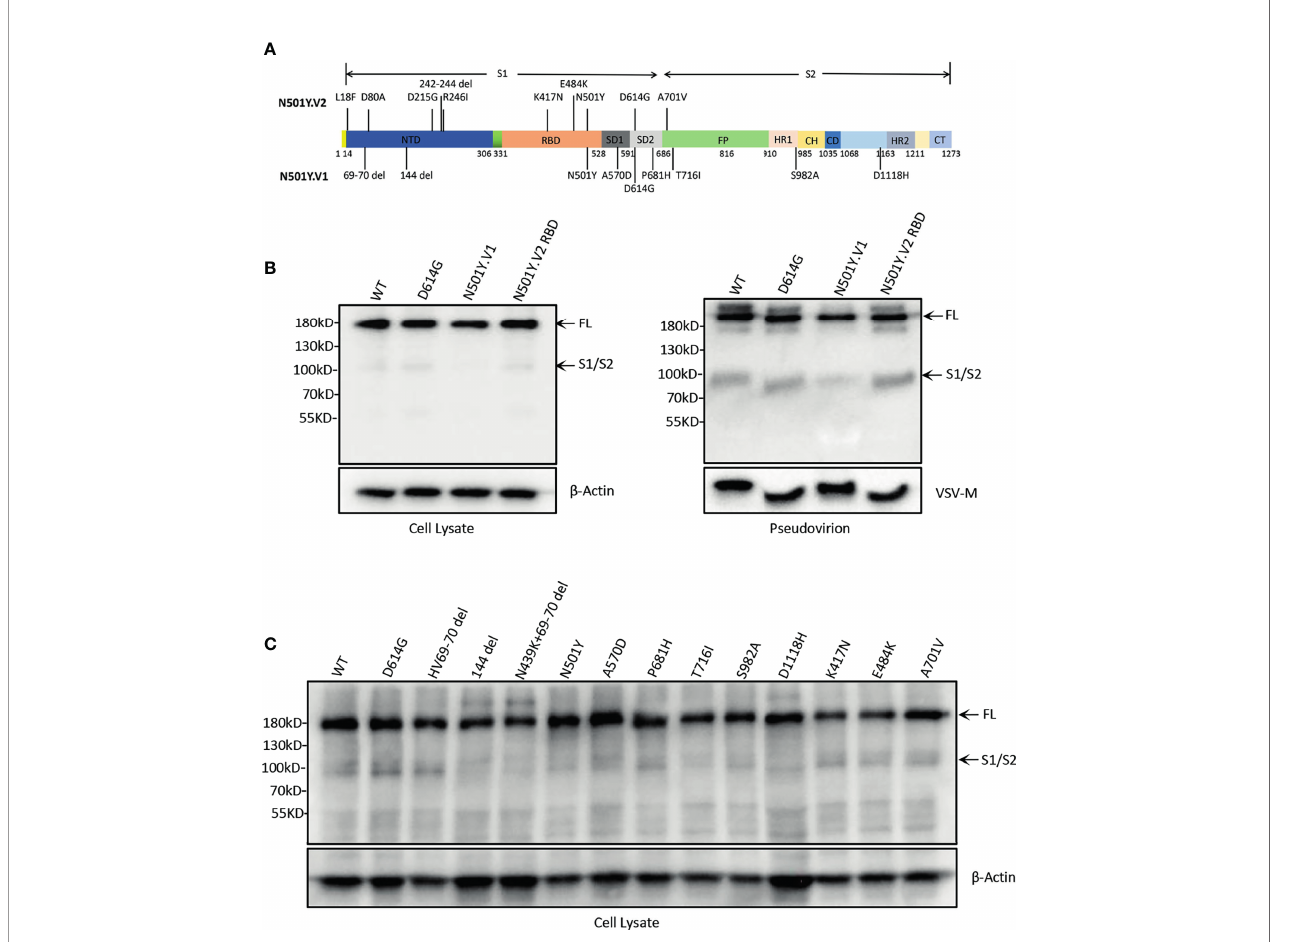
FIGURE 1 | SARS-CoV-2 variants spike protein expression and incorporation into pseudovirions. (A) Construction of SARS-CoV-2 variants N501Y.V1, N501Y.V2, and N501Y.V2 RBD S protein. The S protein of N501Y.V1 include nine mutations (HV69-70 del, 144 del, N501Y, D614G, P681H, T716I, S982A, and D1118H), N501Y.V2 include ten mutations (L18F, D80A, D215G, 242-244 del, R246I, K417N, E484K, N501Y, D614G and A701V) and N501Y-V2 RBD include D614G and three major mutations in the RBD (K417N, E484K and N501Y). (B) Analysis of S protein expression and particle incorporation of N501Y.V1 and N501Y.V2 RBD lineages. The S proteins expression and incorporation to pseudovirion were measured by western blot using antibody against spike. b -Actin (cell lysates) and VSV-M (particles) served as loading controls. Full-length S protein and S1/S2 cleavage are annotated. Shown are representative blots from three experiments. (C) Analysis of the S protein expression of single-site mutation of spike protein in N501Y.V1 and N501Y.V2 lineages by western blot. The S proteins expression were detected in cell lysate by western blot using antibody against S protein, and b -Actin served as loading